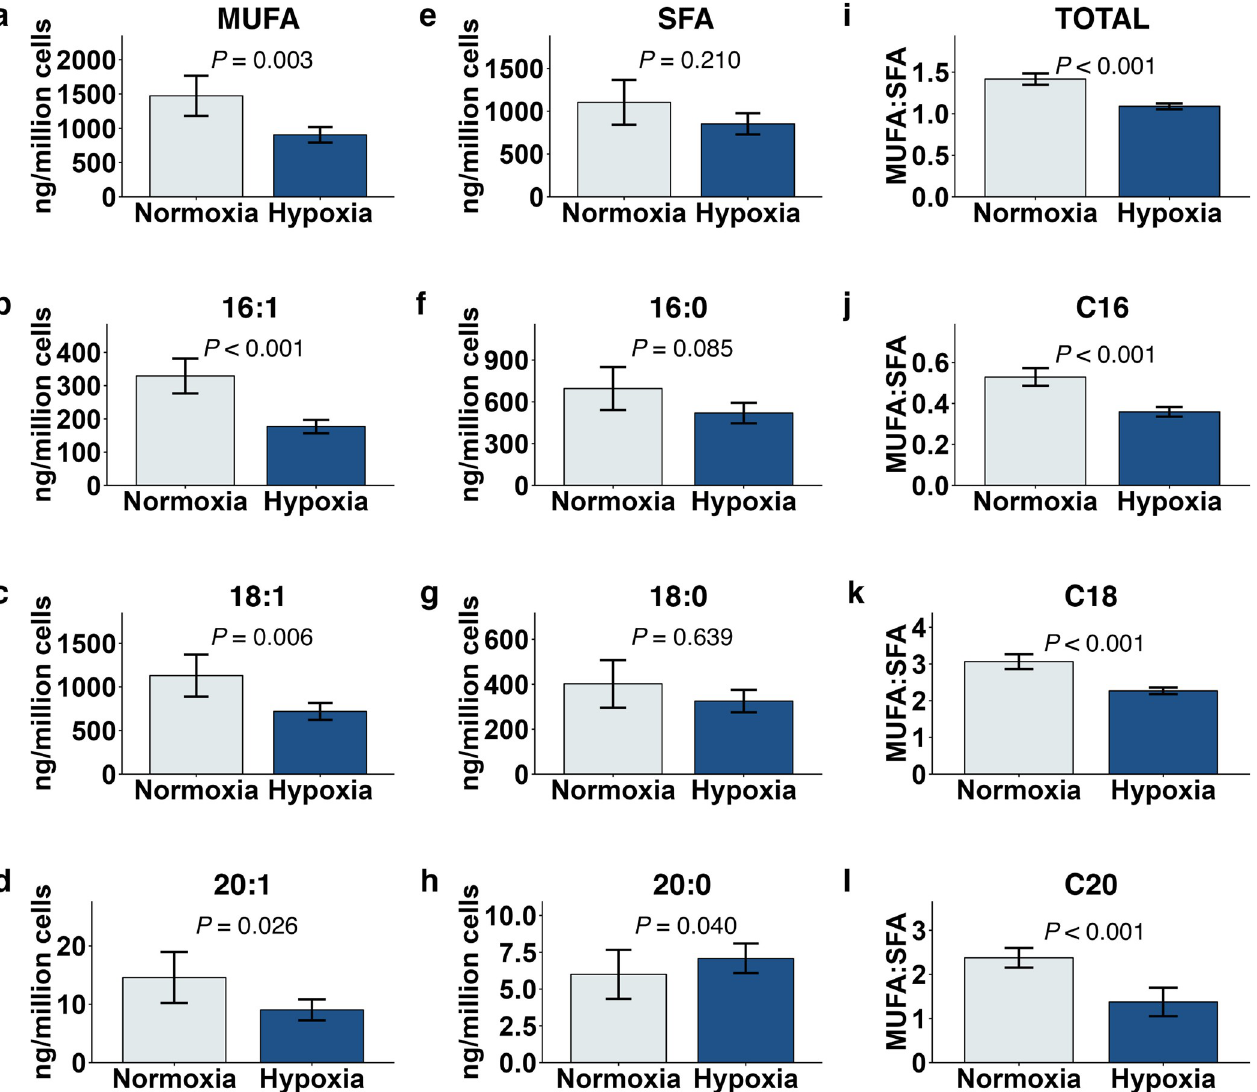
Fig 4. Hypoxia reduced mono-unsaturated fatty acid concentrations in UFH-001 cells independent of BCP. UFH-001 cells were exposed to normoxic or hypoxic conditions in the presence of BCP for 16h. At the end of the incubation, cells were washed and processed for lipid extraction as described in Methods. (a-d) MUFA and (e-h) SFA species as a whole or by individual acyl chain lengths; data are ng/million cells. (i-l) MUFA:SFA ratios as a whole or by individual acyl chain lengths. Bars represent means ± S.E.M of 9 biological replicates. P -values reported are the main effect of OS from the mixed model ANOVAs.